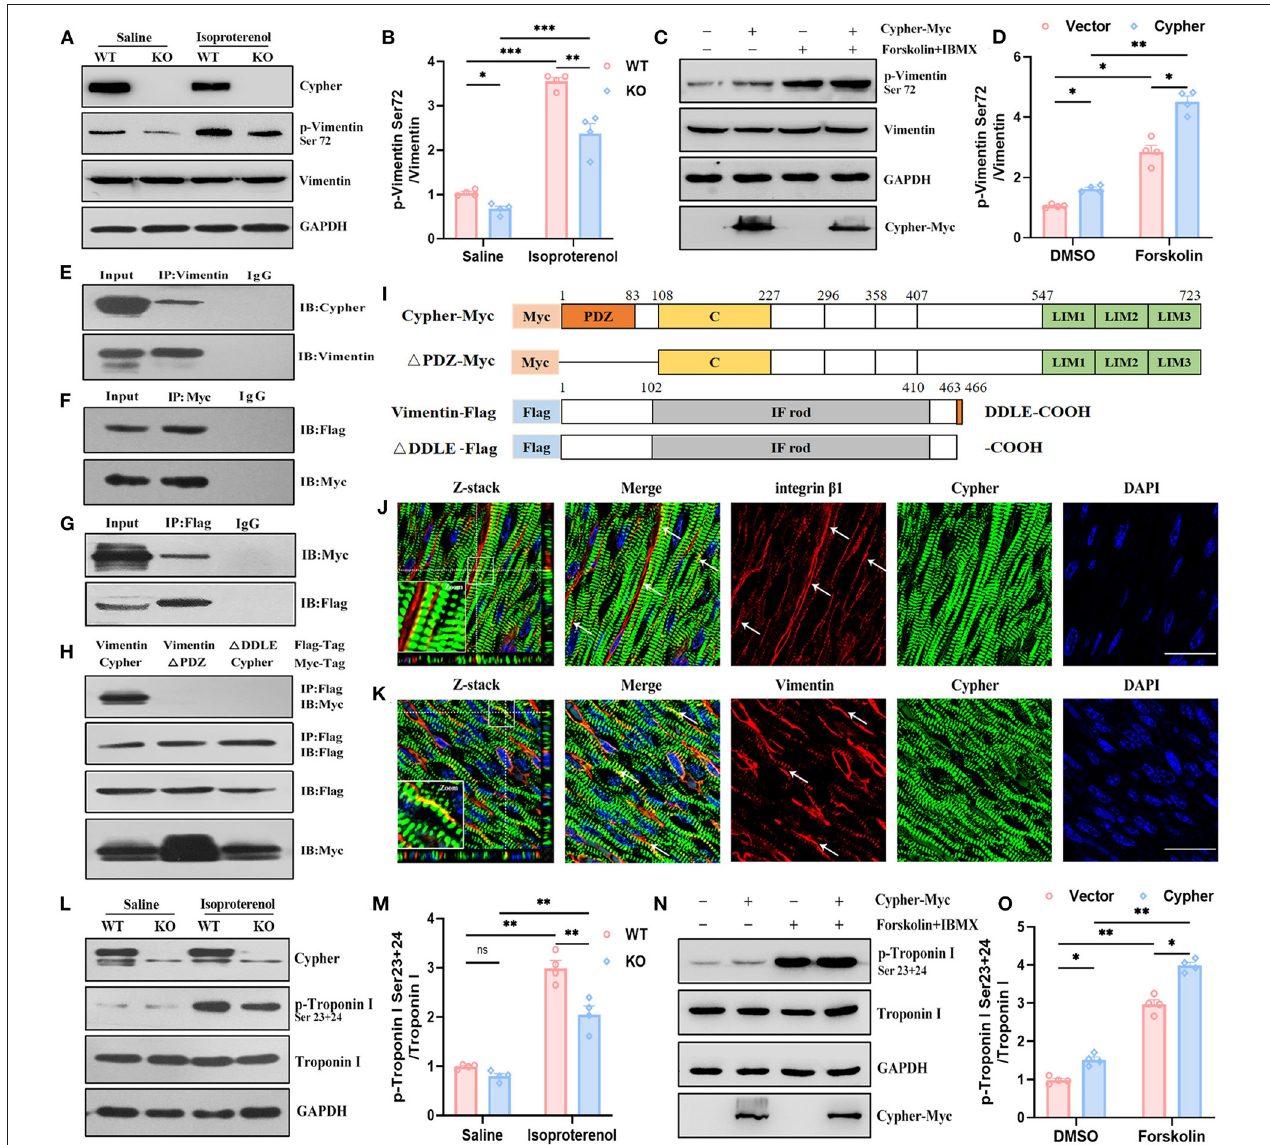
FIGURE 6 | Validation of vimentin and troponin I as PKA substrates regulated by Cypher. (A,B) Heart lysates from neonatal WT and Cypher-KO mice were analysed for total and phosphorylated vimentin. The mice were administered isoproterenol (15 mg/kg, 30min) prior to sacrifice. Quantitative p-vimentin (Ser72) are shown (B) . N = 4 biologically independent samples. (C,D) HEK293T cell lysates with Cypher overexpression were analysed for total and phosphorylated vimentin. Forskolin (100 µ M, 30min) and IBMX were used for activating PKA. p-Vimentin (Ser72) was quantitatively measured (D) . N = 4 biologically independent samples. (E) Vimentin interacted with Cypher in vivo . Vimentin was enriched from neonatal mouse heart lysates, and interaction with Cypher was verified using anti-Cypher antibody. Rabbit IgG served as the negative control. (F,G) Coimmunoprecipitation (Co-IP) and reverse Co-IP experiments were performed to test the interaction between Cypher and vimentin in HEK293T cells. (F) Myc-tagged Cypher was enriched using anti-Myc antibody, and the interacting protein was probed with anti-Flag antibody. (G) Flag-tagged vimentin was enriched using anti-Flag antibody, and the interacting protein was analysed using anti-Myc antibody. (H) The Cypher PDZ domain interacted with the vimentin C-terminal PDZ-binding motif (DDLE). Myc-tagged Cypher or its PDZ domain deletion mutant ( 1 PDZ-Myc) and Flag-tagged vimentin or its deletion mutant ( 1 DDLE-Flag) were cotransfected into HEK293T cells. Immunoprecipitation was performed using anti-Flag antibody, and the samples were further probed with anti-Myc antibody. (I) Schematic presentation of Myc-tagged and Flag-tagged proteins mentioned in (H) . C, cardiac specific region; IF rod, intermediate filament rod domain. (J) Colocalisation (arrows) of Cypher and integrin β 1 indicated that Cypher partially localised to costameres. The white box indicates the magnified regions. Z-stack images with 0.15 µ m Z-steps were imaged from neonatal heart sections. (K) Immunofluorescence confocal images illustrated the colocalisation of Cypher and vimentin in costameres, as indicated by arrows. The white box indicates the magnified regions. Scale bars: 25 µ m. (L) Troponin I and its phosphorylation using neonatal heart lysates were detected by western blotting. Isoproterenol (15 mg/kg, 30min) was administered before the hearts were collected. (M) Quantification of p-troponin I (Ser23 + 24) protein levels in heart lysates. N = 4 biologically independent samples. (N) Myc-tagged Cypher and Flag-tagged troponin I were coexpressed in HEK293T cells with forskolin (100 µ M, 30min) for activating PKA. Total and phosphorylated troponin I were analysed by western blotting. (O) Quantification of p-troponin I (Ser23 + 24) protein levels in cell lysates. N = 4 biologically independent samples. *, p < 0.05;**, p < 0.01; ***, p < 0.001. Error bars indicate the mean ± SEM. Two-way ANOVA (B,D,M,O) with Bonferroni multiple comparison test was applied.